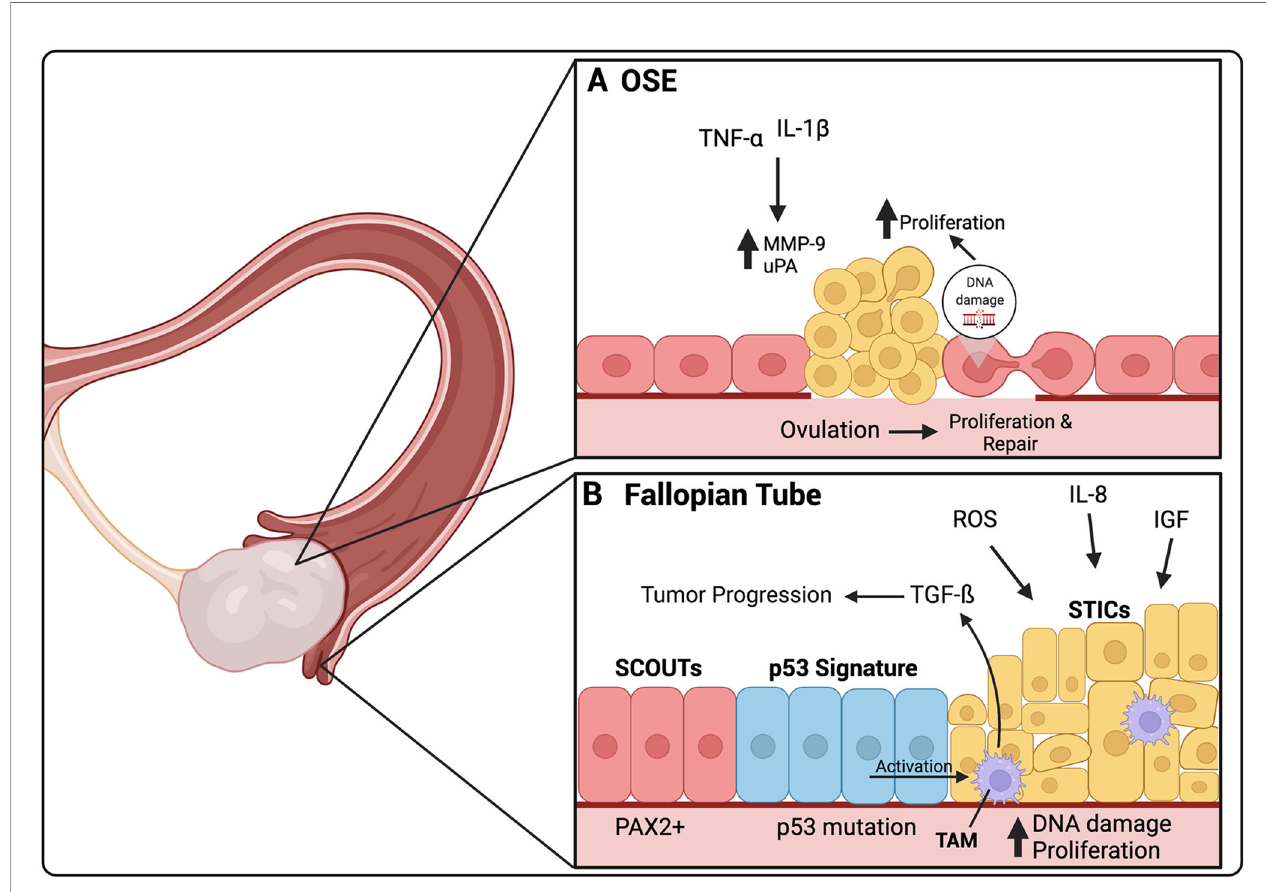
FIGURE 1 | The origin of HGSOC is thought to be either in the secretory cells of the fallopian tube or the ovarian surface epithelium (OSE). (A) Ovulation induces a constant damage and repair cycle in the OSE. In certain cases, these constant DNA repair cycles can cause DNA damage, leading to uncontrolled proliferation of the OSE. TNF- a and IL-1 b are present in the in fl ammatory environment created by ovulation. They increase the expression of MMP-9 and uPA, both involved in ECM repair after ovulation, but have also been linked to HGSOC premetastatic lesions. (B) SCOUTs, an extended area of secretory cells, are thought to be the initial precursor lesion for HGSOC. SCOUTs then evolve into p53 signature, secretory cells that have developed p53 mutations. STICs are thought to be the immediate precursor lesion of HGSOC. ROS, IL-8 and IGF released during ovulation, are thought to cause increases in DNA damage leading to increased proliferation of STIC and development into HGSOC. Activated TAMs can be found in STIC lesions, secreting TGF- b , which contributes to tumor progression. TAMs are activated by p53 mutant cells within STIC lesions. Created with